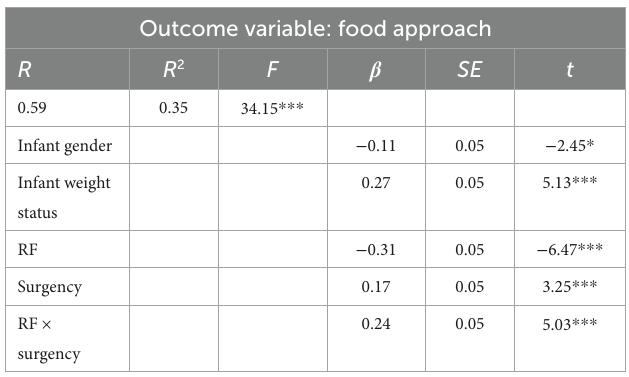
TABLE 3 Results for the moderating effect of surgency on the relationship between RF and food